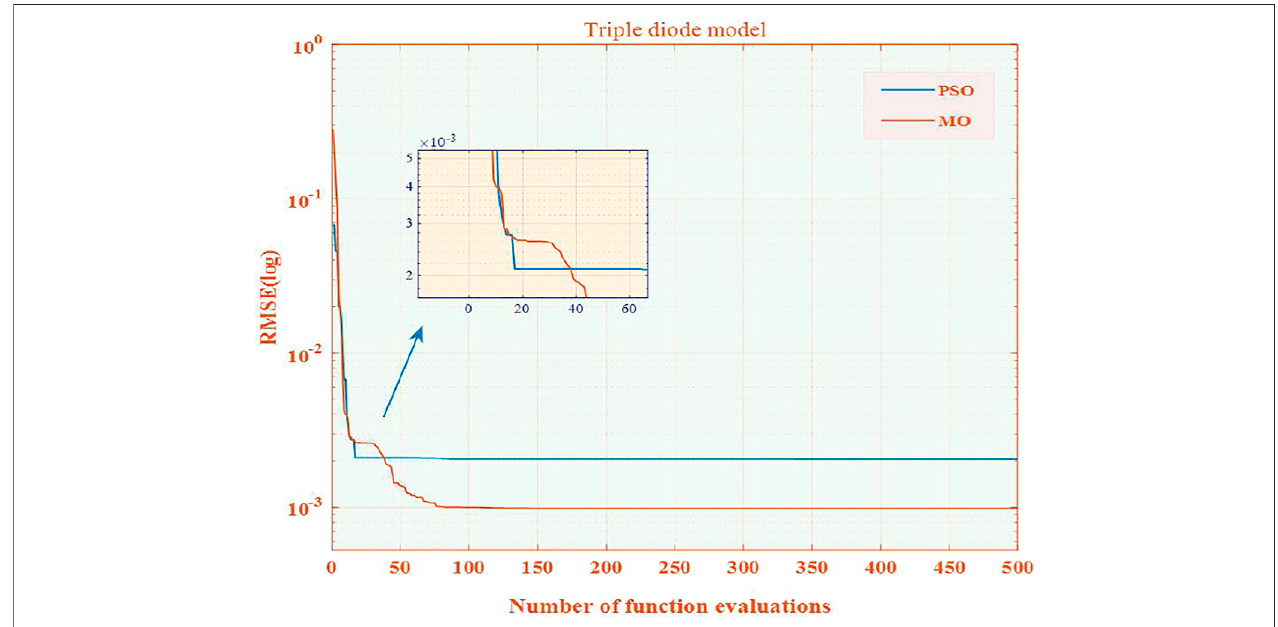
FIGURE 4 | Convergence graph of various algorithms for the TDM.